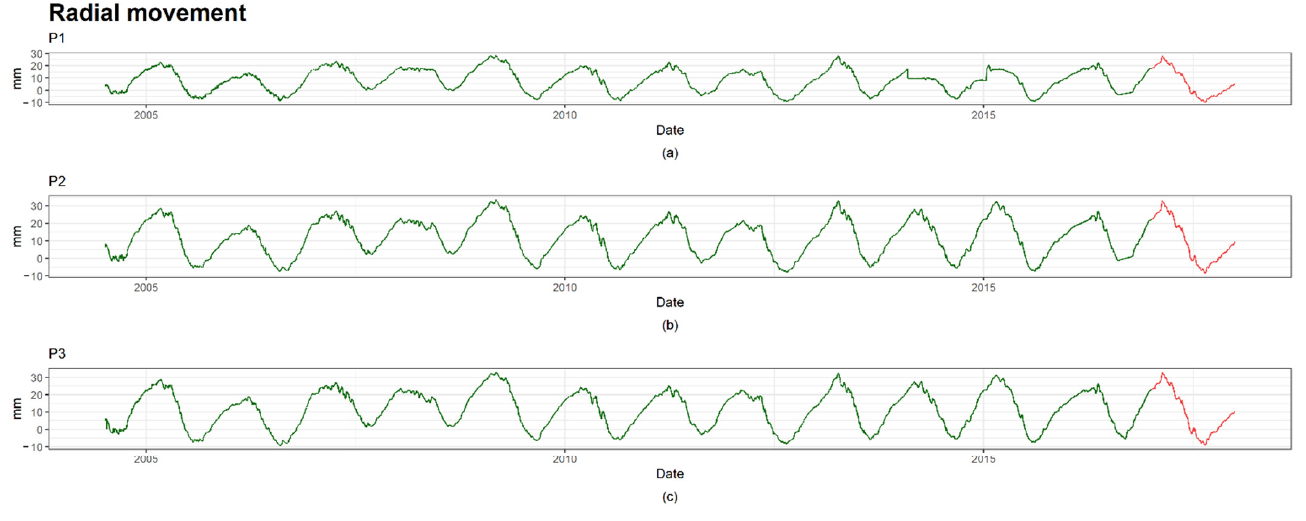
Figure 9. Series of direct pendulums. Training instances are colored in green and validation dates are colored in red. ( a ) Series of pendulum 1; ( b ) Series of pendulum 2; ( c ) Series of pendulum 3; ( d ) Series of pendulum 4. 3. Results and Discussion This section presents and discusses the results obtained by applying the proposed methodology to the dam described in the previous section. It has been divided into two subsections, following the outline shown in Figure 1. 3.1. Cross Validation Table 2 shows two different RMSE values for both strategies: RMSE cv and RMSE val . The first measures the error (RMSE) during the Cross Validation process, which is the mean of the RMSE values across folds. The second refers to the error over the validation set [24]. The third measure is the relative difference between both errors calculated by the following formula: RD (cid:3038) = RMSE (cid:2887)(cid:2906) (cid:3169) − RMSE (cid:2932)(cid:2911)(cid:2922) (cid:3169) RMSE (cid:2887)(cid:2906) (cid:3169) × 100; (5) where 𝑘 ∈ (cid:4668)Random CV, Blocked CV(cid:4669) . As mentioned in previous chapters, it is more robust to use the estimated error obtained during the CV process, because it is calculated using a larger number of instances. However, the RMSE in the validation set should be compared with the RMSE cv value, seeking the smallest difference between them. The negative values of RD in Table 2 show that the error over the validation set is higher than the one estimated by CV. All these values, except one, are negative and quite high in the case of Random CV. They fall within the range of [ − 578.06%, − 8.26%], excluding the result of HST, which can be considered atypical. Those of Blocked CV are signi fi cantly lower, as they fall within the range of [ − 62.14%, 25.81%]. The mean RD of Random CV is − 210.56%, while the mean RD of Blocked CV is − 8.23%. Therefore, the error estimated during the Annual CV, or Blocked CV, is considered a preferable estimator for future data.